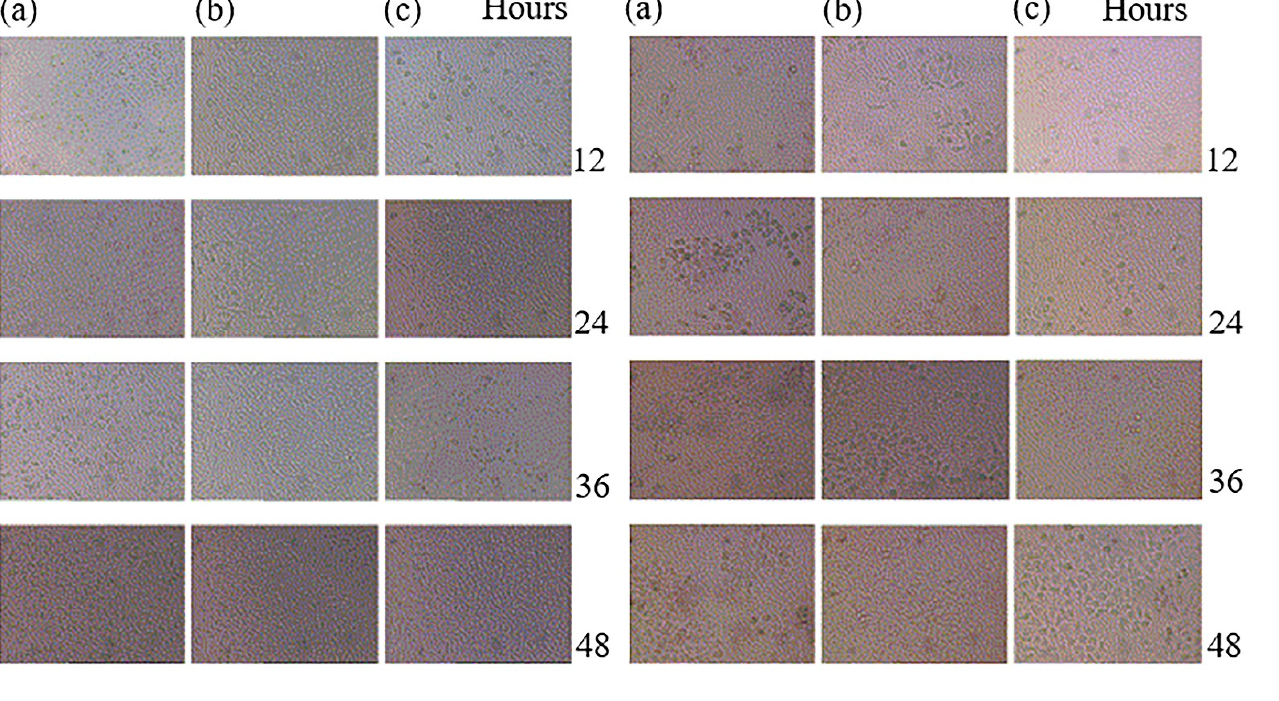
Figure 6. Microscopy photographs of cells after 12, 24, 36, and 48 h of plating. Set 1, L929 ( a ) chitosan grafted PLLA, ( b ) pristine PLLA, and ( c ) glass control. Set 2, L02 ( a ) chitosan grafted PLLA, ( b ) pristine PLLA, and ( c ) glass control [242], with permission from Elsevier, 2004.